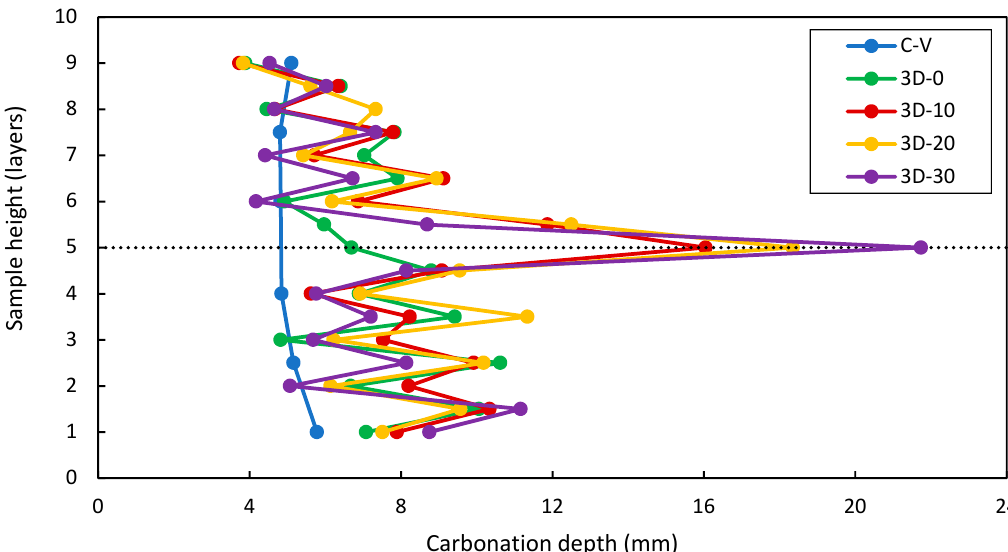
Figure 17. 12-week carbonation front profile for all the experimental variables, where the CL is in- dicated by the black dotted line.